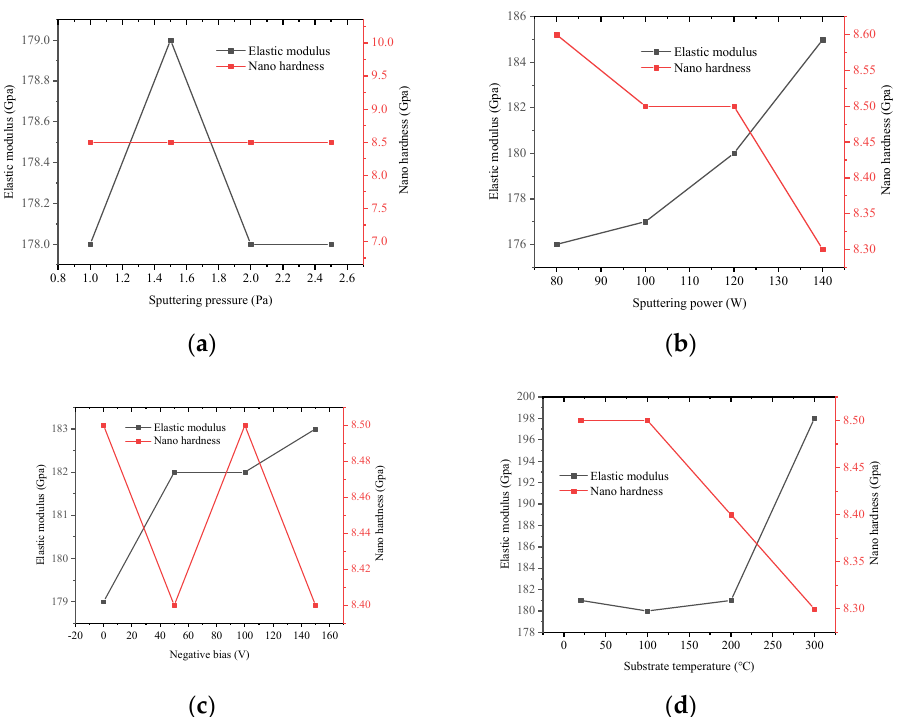
Figure 6. Effect of different process parameters on elastic modulus and nano-hardness. ( a ) Sputtering pressure curve; ( b ) Sputtering power curve; ( c ) Substrate negative bias curve; ( d ) Substrate temperature curve.